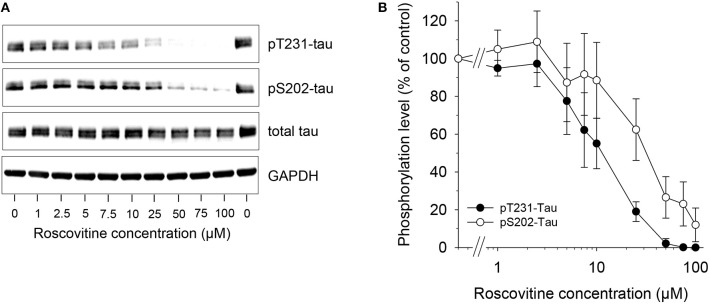
Dose-dependent down-regulation of tau phosphorylation is induced by roscovitine. SH-SY5Y-(P301L) cells were exposed for 6 h to a range of roscovitine concentrations. Cells were harvested and proteins were resolved by SDS-PAGE followed by western blotting (Left) with antibodies to pThr231 (Mab RZ3), pSer202 (Mab CP13), and T-tau (Mab DA31). α-GAPDH was used as a loading control. Western blotted protein bands were quantified (mean ± SE of three independent experiments) (Right).